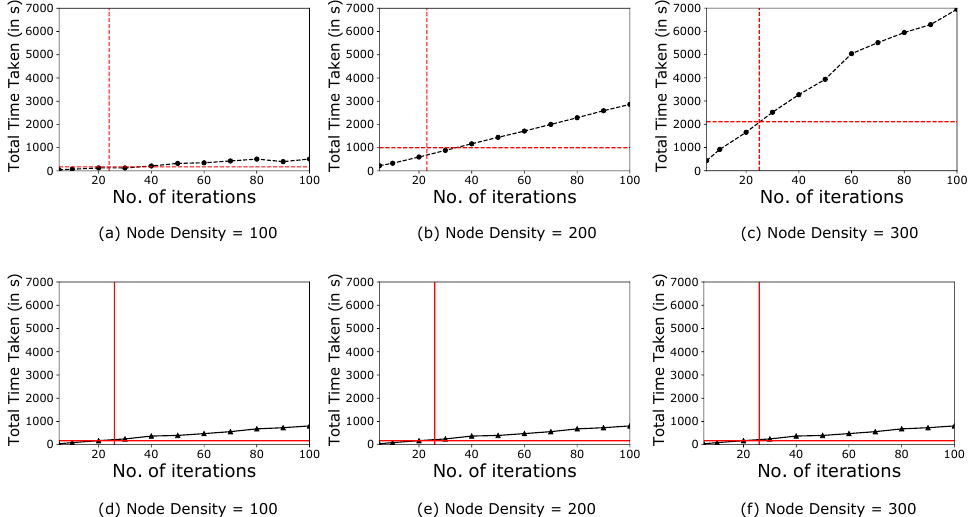
Figure 6. Variation of total time taken with respect to the number of iterations for a transmission range of 15 m over a monitoring area of 100 m × 100